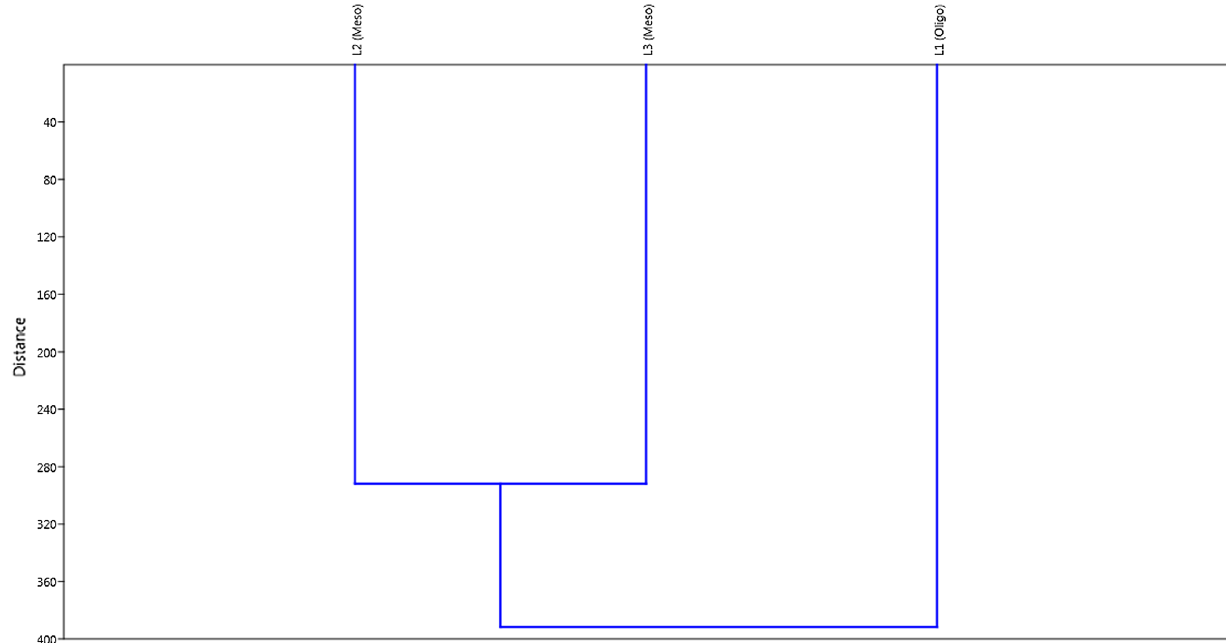
Fig. 3 Cluster Analysis of water quality parameters from the selected lakes (i.e., Lake 1 = L1 (Oligo), Lake 2 = L2 (Meso) and Lake 3 = L3